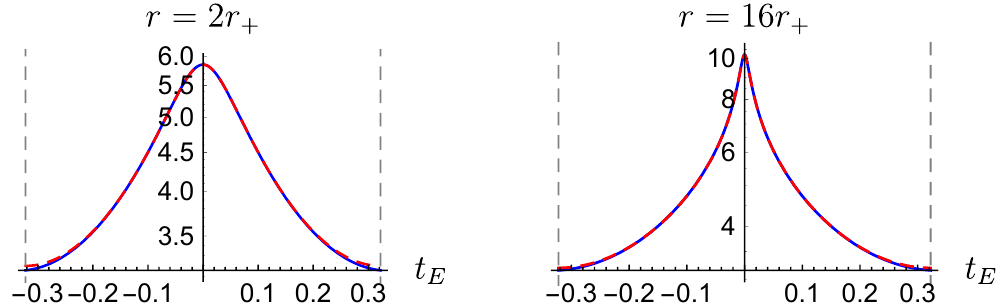
exact )) and semiclassical (pink, log( 0 j jV